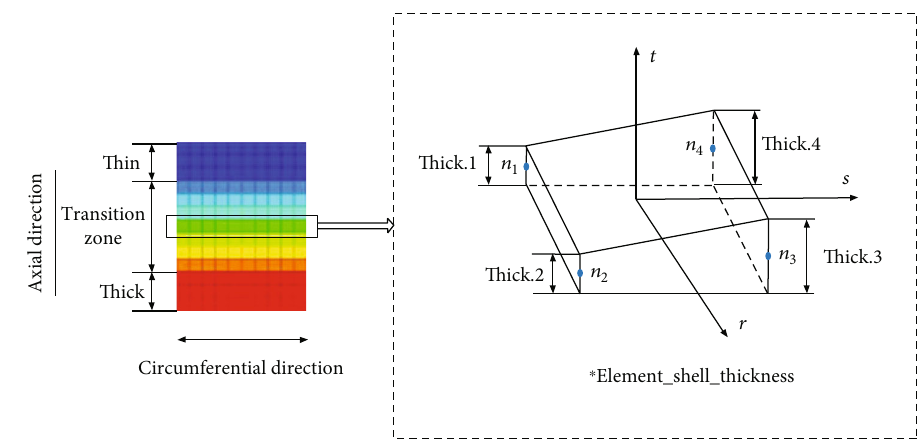
Figure 5: Schematic of FE modeling of TRBs.